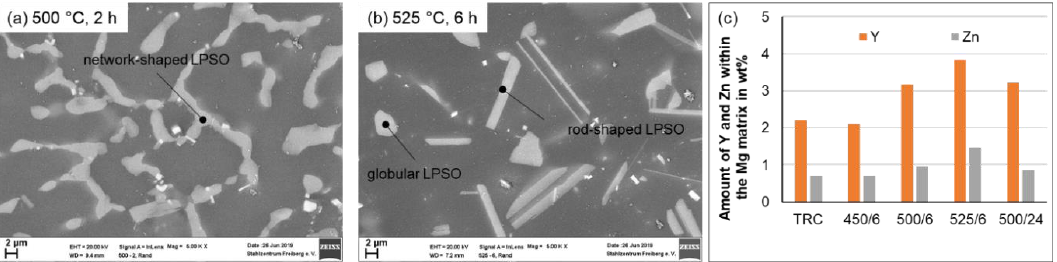
Figure 5. SEM micrographs of the twin-roll cast and annealed WZ73 alloy at ( a ) 500 °C, 2 h, ( b ) 525 °C, 6 h and ( c ) the amount of Y and Zn within the magnesium matrix (mid-thickness of the strip) for different conditions: TRC and after annealing at °C/h.